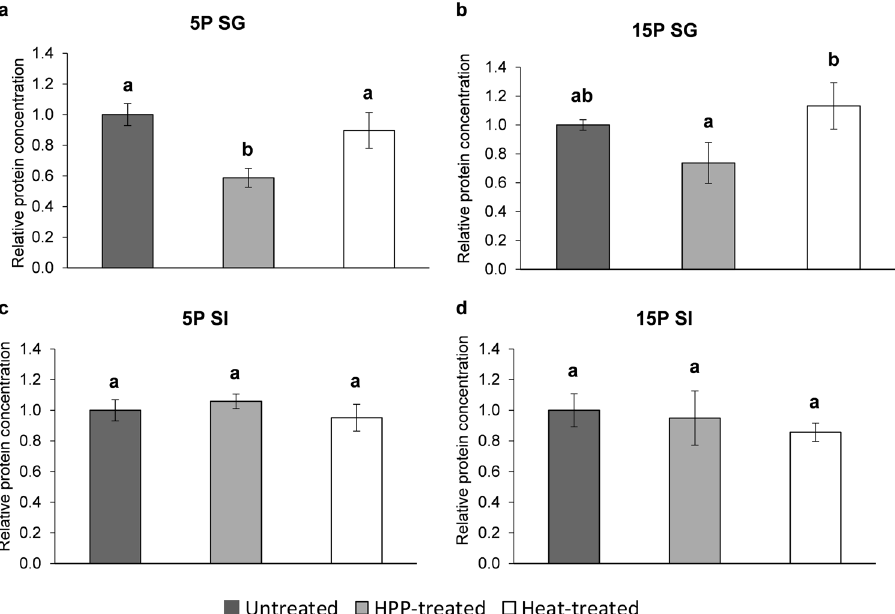
Fig. 2 Average relative protein concentration in un fi ltered SG and SI separated by SDS-PAGE. The average relative protein concentrations (unitless) in un fi ltered SG after static gastric in vitro digestion of a pea protein concentrate with 5% (w/w) protein (5 P) and b pea protein concentrate with 15% (w/w) protein (15 P), and in un fi ltered SI after completion of static in vitro digestion of c 5 P and d 15 P were calculated with respect to the average untreated protein concentration for SG and SI of 5 P and 15 P, separately (average protein concentration/average protein concentration of untreated). SG was the static model cumulative gastric digesta and SI was the static model cumulative intestinal digesta, see Table 1 for all symbol descriptions. Gels were run for each independent replicate of digestions in technical duplicate, where the protein concentrations for each independent digestion were an average of the technical duplicates. Bar height represents the average relative protein concentration for the three independent digestions. Error bars display the standard deviation. Letters above the bars indicate statistically signi fi cant differences ( p < 0.05). SG and SI were analyzed by the statistical model